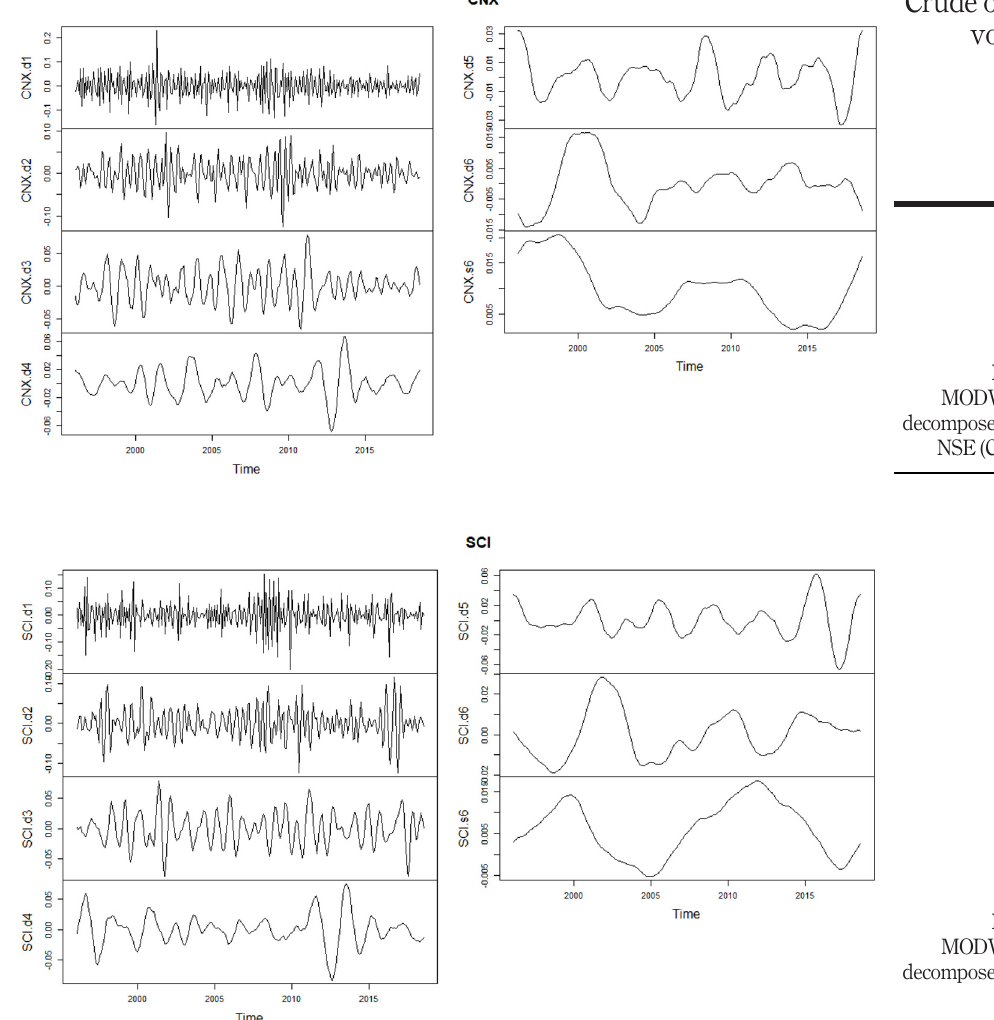
Figure 3. MODWT plot of